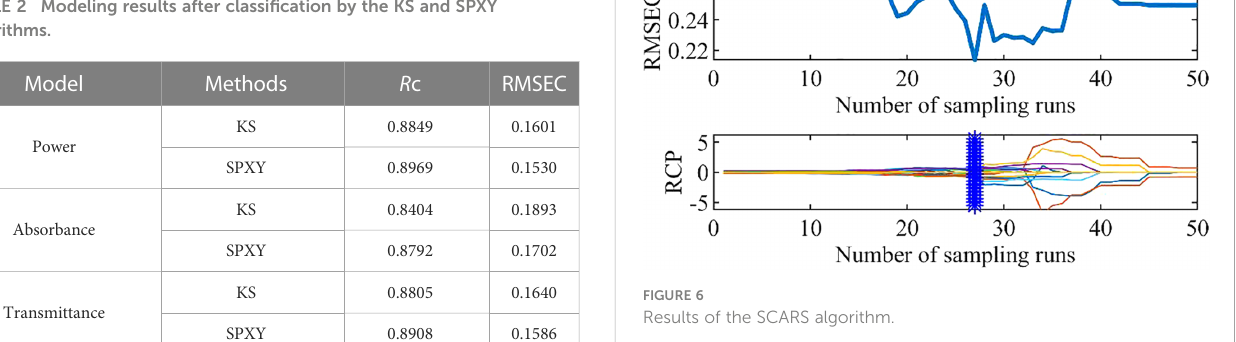
FIGURE 6 Results of the SCARS